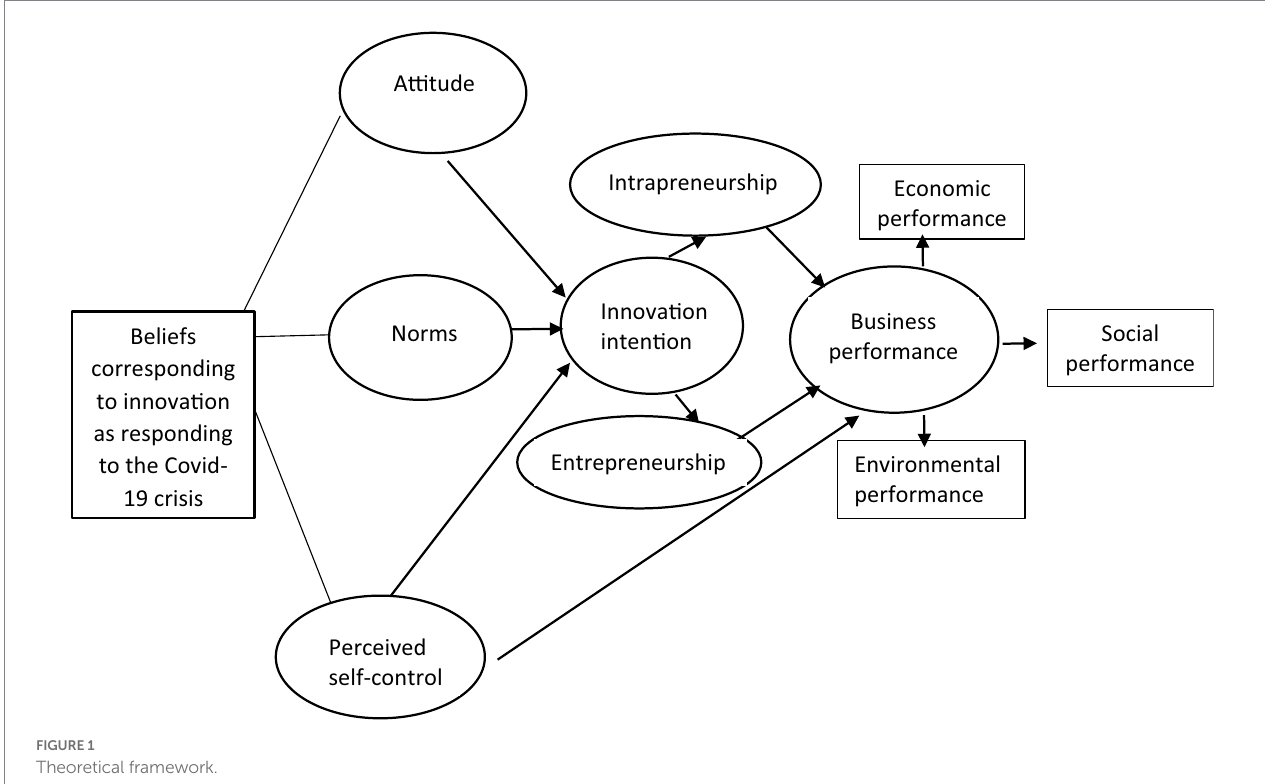
FIGURE 1 Theoretical